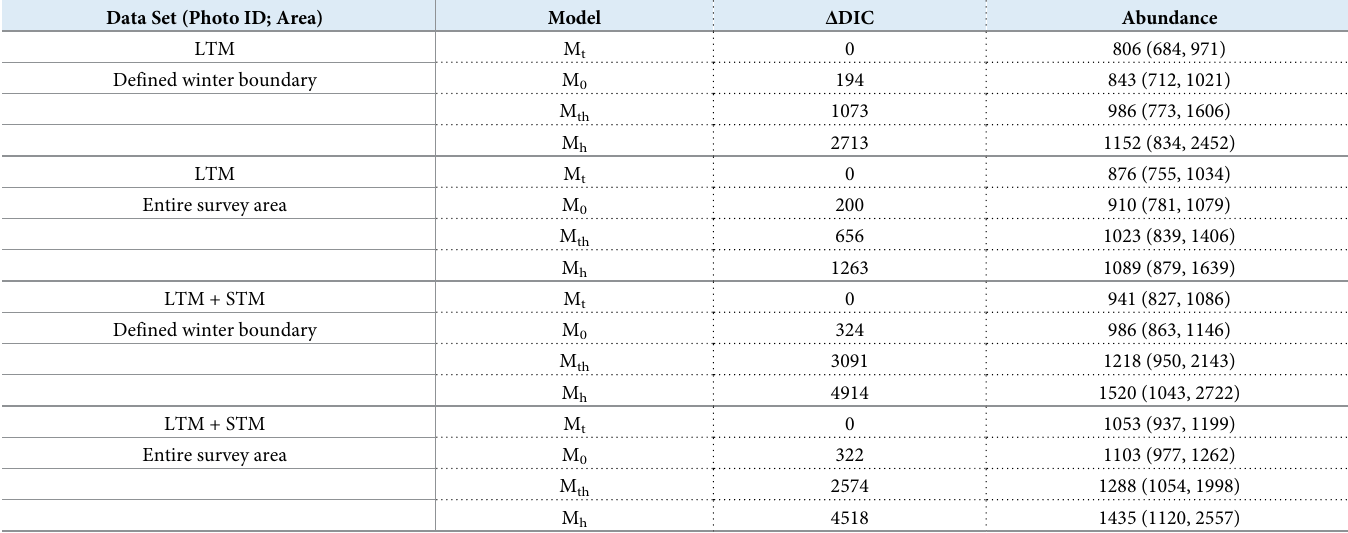
sighting probability estimated higher abundances than those without; however, we reiterate that with only three sampling occasions, those models with random effects can produce Table 8. Estimates of abundance from a winter 2018 capture-mark-recapture survey of estuarine-resident bottlenose dolphins ( Tursiops truncatus ) in southern North Carolina. Data Set (Photo ID;